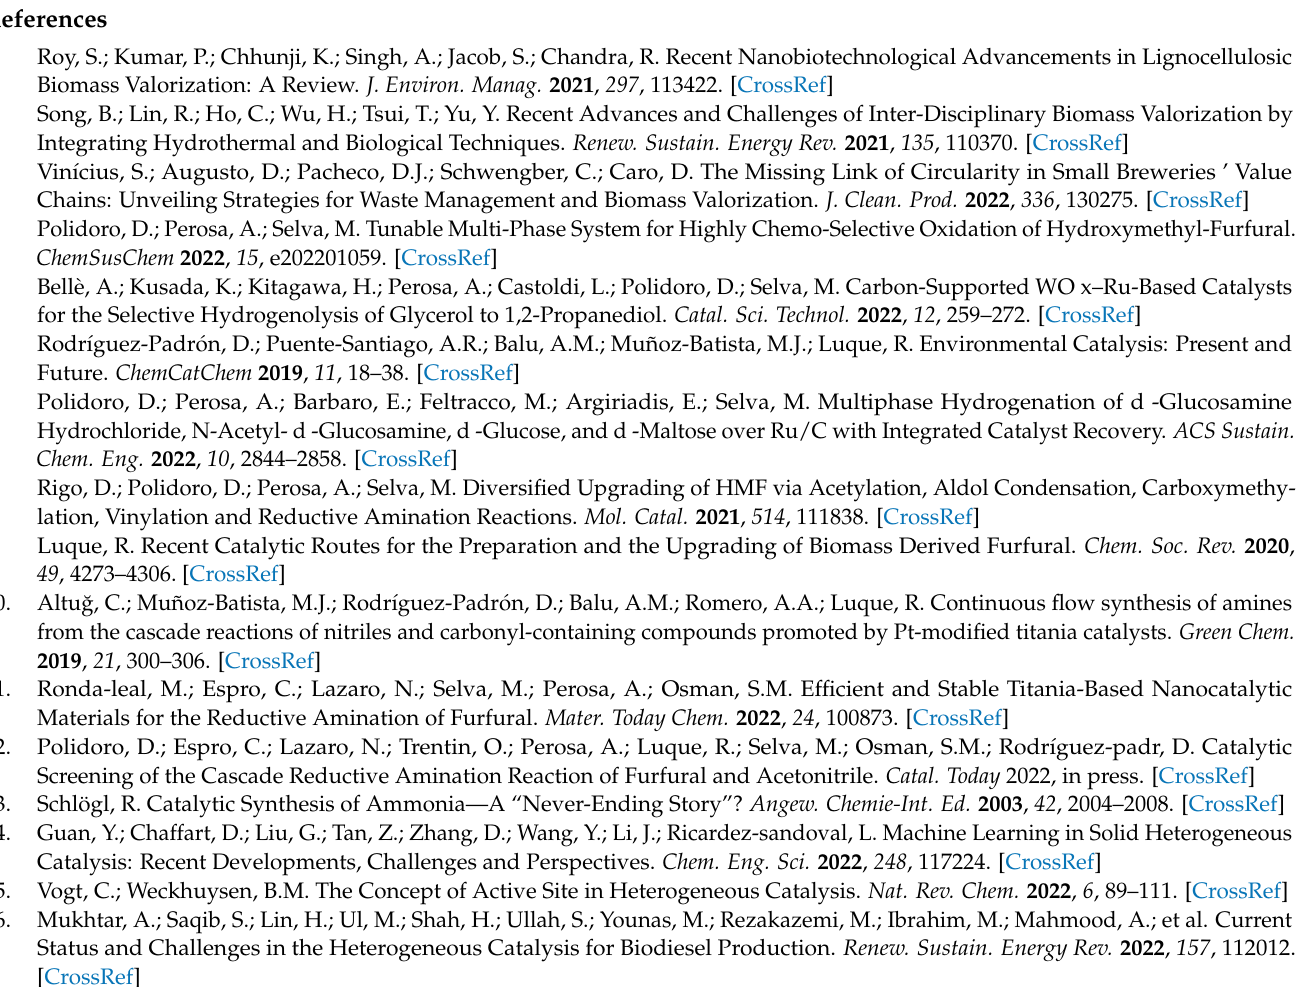
Figure S2. Mass Spectrum of 4a (EI, 70 eV). Figure S3. Mass Spectrum of 4b (EI, 70 eV). Figure S4. Mass Spectrum of 4c (EI, 70